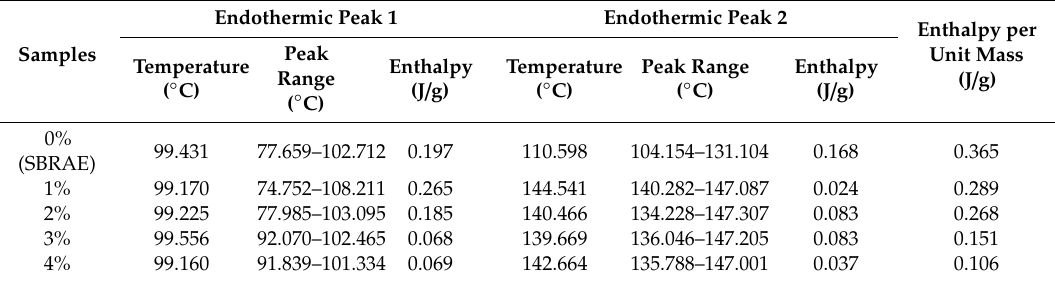
Figure 5. Evaporation residue thermal curves for WESAE and SBRAE. Table 4. Evaporation residue thermal parameters for WESAE and SBRAE.